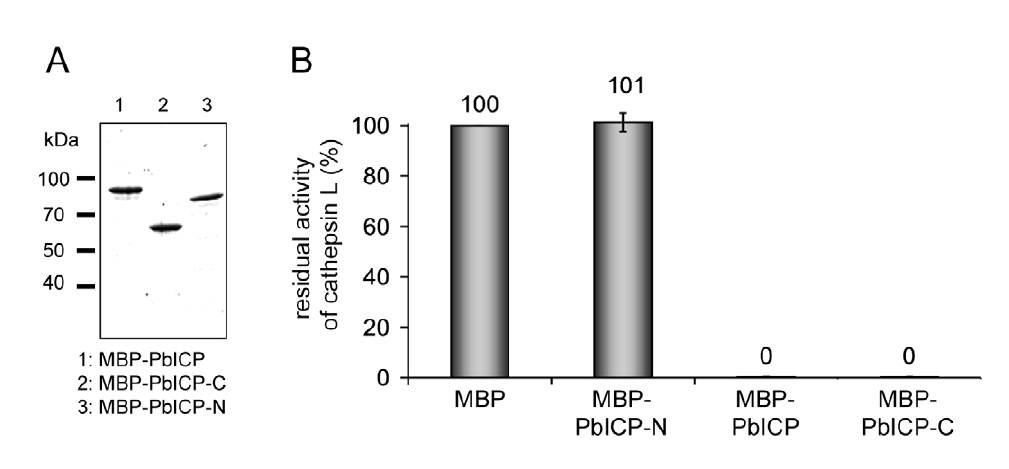
Figure 6. The C-terminal domain of PbICP is necessary and sufficient for the inhibitor function. ( A ) Purification of recombinant PbICP, PbICP-C and -N. Like the full-length protein, recombinant PbICP-C and -N were expressed in E. coli as MBP-tagged soluble proteins and purified from the bacterial total lysate by amylose-bead affinity chromatography (lane 1, 2, 3). The proteins were resolved by SDS-PAGE and stained with Coomassie Blue. ( B ) Recombinant PbICP-C inhibits the cysteine protease cathepsin L to a similar extent as full-length PbICP, whereas PbICP-N does not block cathepsin L activity. Hydrolysis of the substrate Z-FR-pNA by cathepsin L was measured in the presence of 1 m M MBP-PbICP-N, MBP-PbICP or MBP-PbICP-C or the control protein